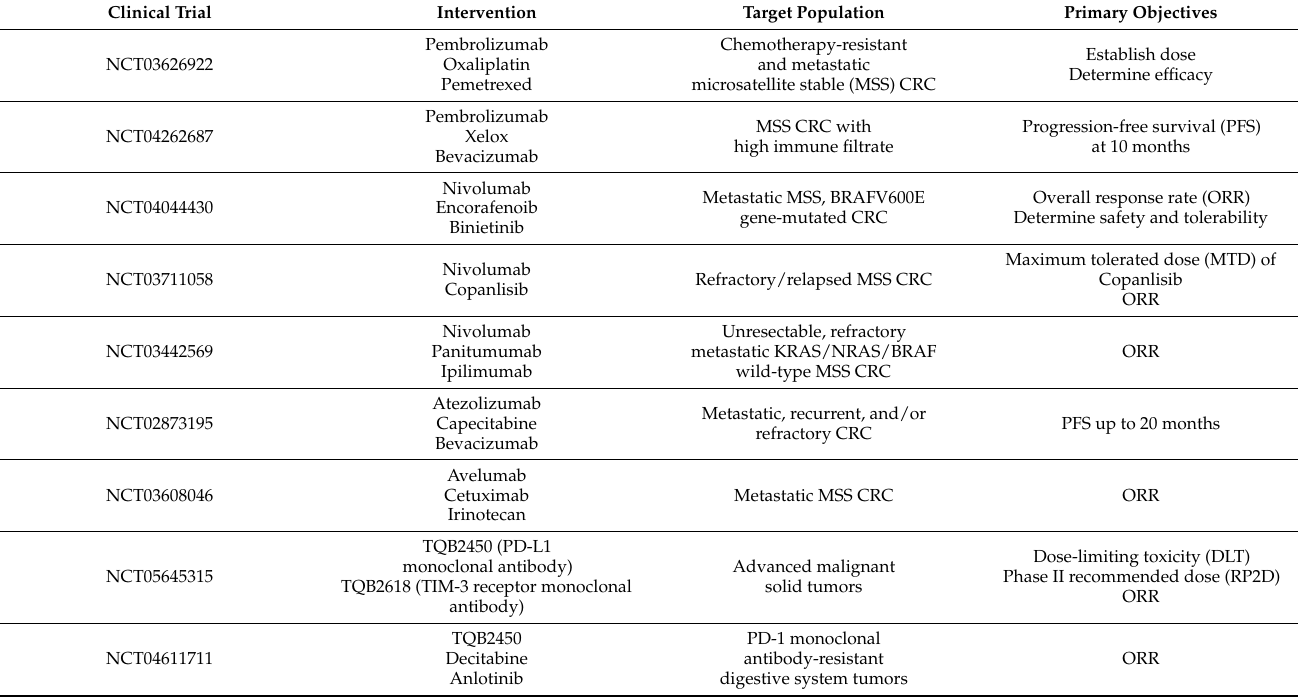
Table 1. Clinical trials evaluating immune checkpoint inhibitors (ICIs) in combination with chemother- apy, radiation, and/or other ICIs for colorectal cancer (CRC). Included also are trials evaluating clinically designed antibodies and fusion proteins in